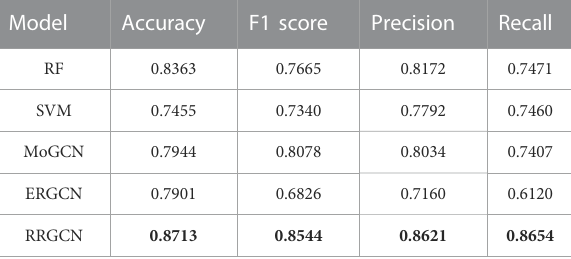
Bold values are to highlight the performance of our model over other classical